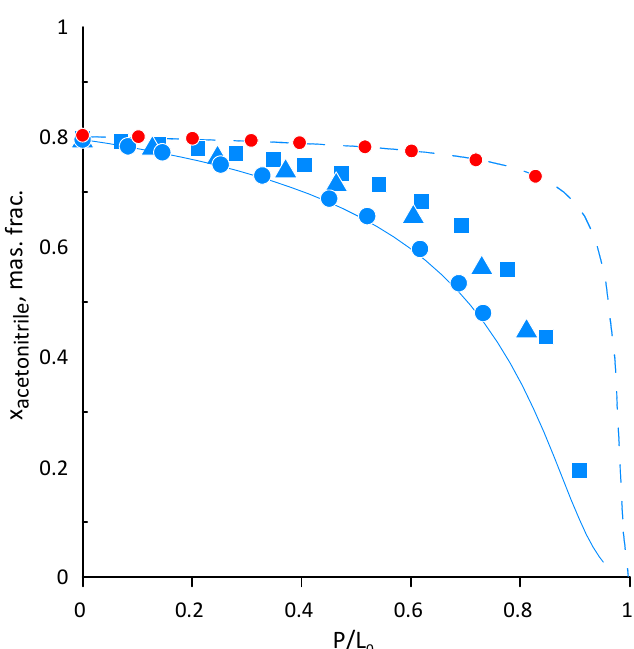
Figure 6. Residual curves for a mixture of acetonitrile-water-AEBC-TEG, geometric figures—experimental data, calculation lines according to the UNIFAC model with corrected parameters. AEBA–TEG concentrations: red circles, dotted line—0 wt.%, square—20 wt.%, triangle—40 wt.%, circle, continuous line—60 wt.%.